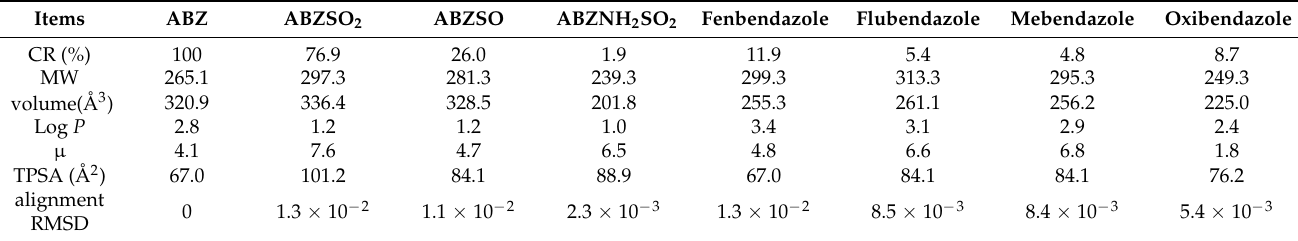
Figure 3. ( a ) The alignment of cross-reactive analytes with ABZ based on lowest energy conformations with all of the hydrogen atoms hidden. ( b ) Electrostatic potential energy of analytes. The negative potential areas are indicated in blue; red coloring indicates positive potential areas, and white indicates relatively neutral areas. The blue and golden globules on the surface represent the minima and maxima of ESP (kcal/mol) on the van der Waals surface. ( c ) The calculated surface area distribution in different ESP ranges on the van der Waals surface. Table 3. Comparison of cross-reactivities and molecular descriptors of benzimidazoles.